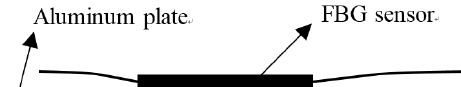
Figure 8. ( a ) Experimental setup of dynamic tests; ( b ) Schematic diagram of experimental setup.